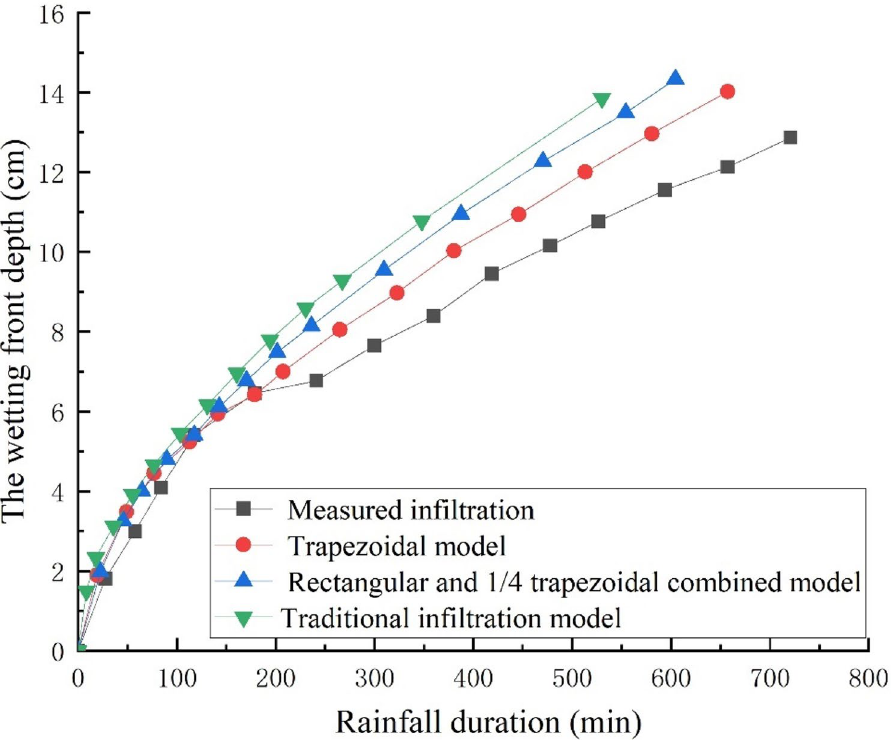
Figure 13. Cumulative infiltration depth and measured